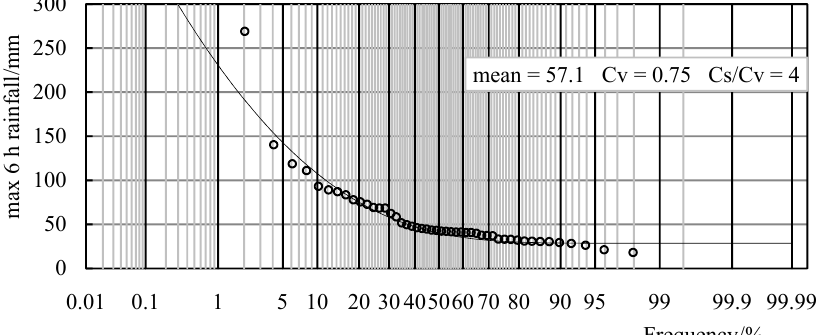
Figure 10. The frequency curve of the maximum 6 h rainfall of discontinuous 48 years in 1964~2021 at Minggao station. Table 4. Frequency analysis parameters and return period of maximum 6 h rainfall of “7.20” flood in 2021 for reference stations.